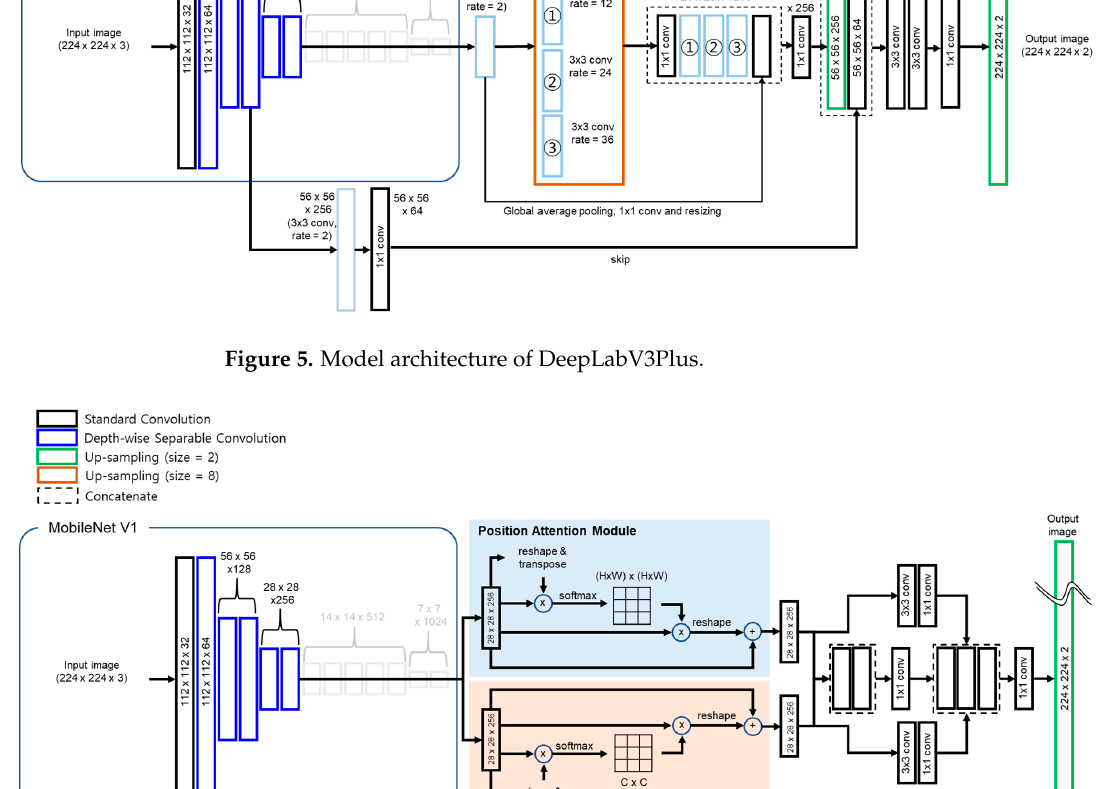
Figure 6. Model architecture of